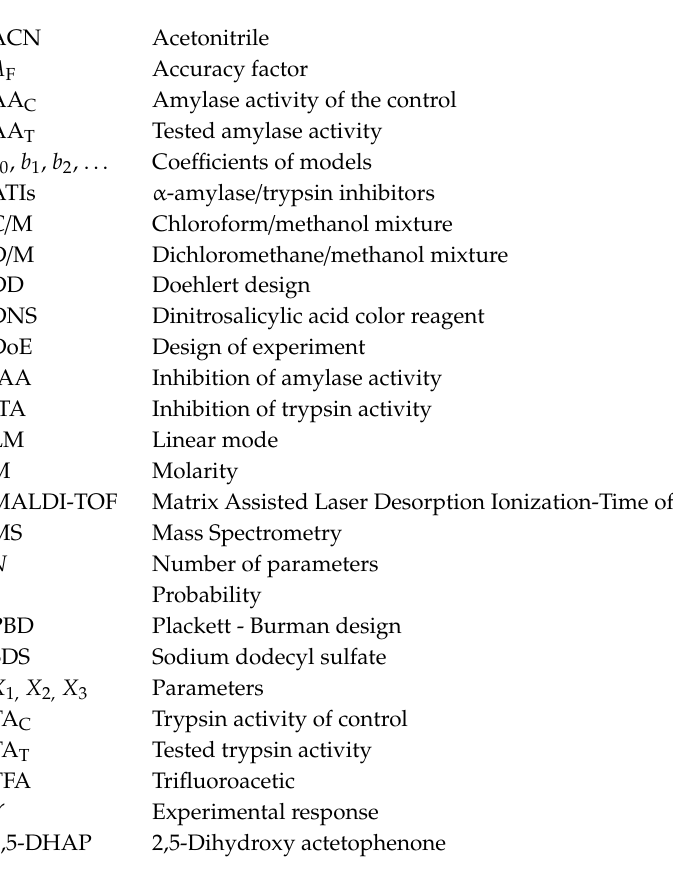
Supplementary Materials: The following are available online, Figure S1: Extraction process of ATIs using Table S1: Protein profiles of (a) Julius extract and (b) Ponticus extract for di ff erent experimental conditions of the Doehlert design determined by SDS-PAGE, Table S1: Experimental factors and their level in Doehlert design, Table S2: Solvent gradient during HPLC fractionation, Table S3: Weighted e ff ects of extraction time sodium chloride concentration and pH on experimental responses expressed in percent, Table S4: Factor coe ffi cients estimated after analysis of Doehlert design and their corresponding R 2 and A f